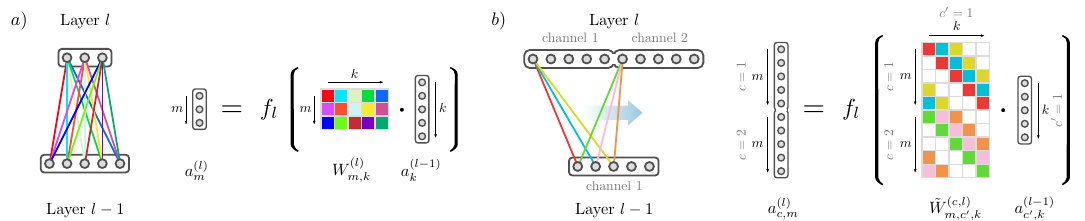
Figure 1: Schematic depiction of the network layers and visualization of the corre- sponding mathematical meaning. a) Dense layer, cf. Eq. (13). Each neuron in layer l is connected to all neurons in layer l − 1 without further structure. b) Convolutional layer, cf. Eq. (26). The connectivity is typically sparse and within a channel the cou- pling of each neuron to the previous layer is obtained by translation as indicated by the arrow and evident from the structure of the coupling matrix. In both cases we omitted possible additional biases that can be added to each